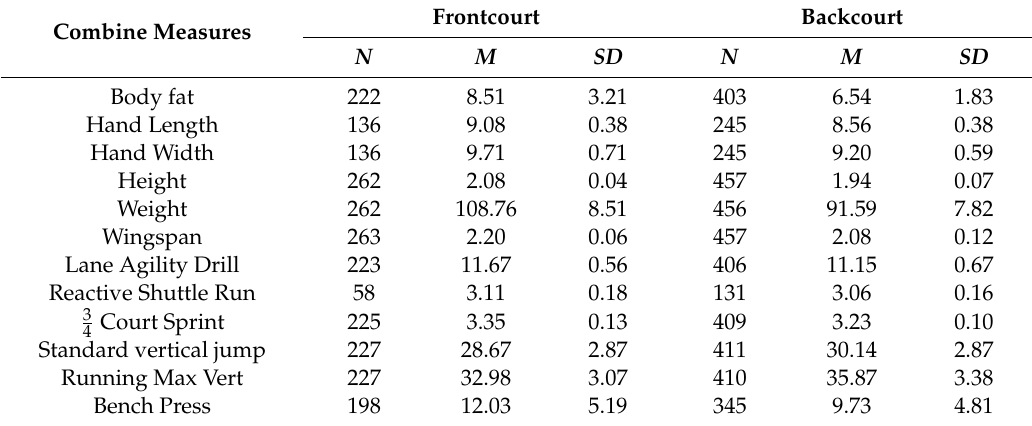
Table 1. Descriptive statistics (M and SD) of the NBA Combine according to player’s